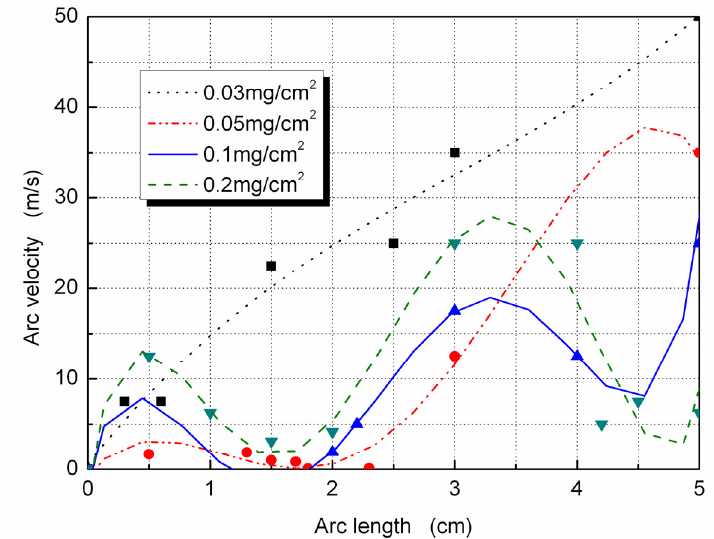
Figure 9. Variation of the measured velocity with the arc